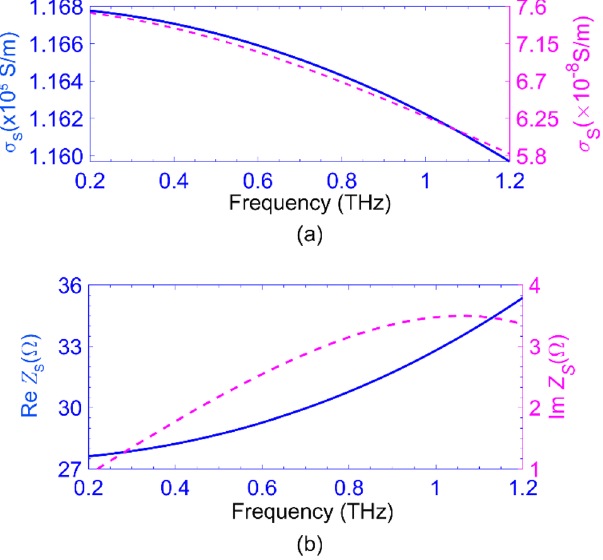
Figure 3. The Drude conductivity σ S versus frequency for n ++ -Si (blue solid) and the entire depleted n-region at V R = 5 V (magenta dashed); (b) Re Z S (solid blue) and Im Z S (dashed magenta) for undepleted n-region at V F = 0.49